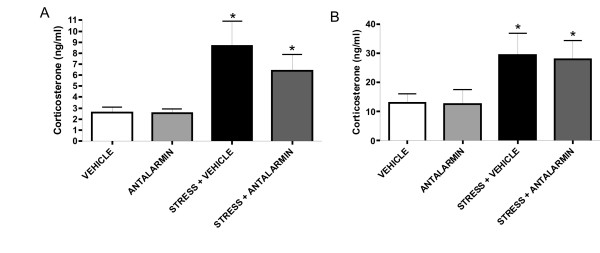
Peripheral administration of antalarmin does not affect the HPA axis response. As described in Materials and methods, levels of corticosterone in serum were determined by RIA in the different groups of mice immediately after the last exposure to stress and on the 4th day of the interval that followed the last exposure to stress. Increased levels of corticosterone upon stress were not affected by the peripheral administration of antalarmin (A). Moreover, increased levels of corticosterone after the last exposure to stress were not affected by antalarmin either, and confirmed the development of chronic stress (B). Data are expressed as MEAN ± SEM. Five animals per group were used. * p < 0.05, compared to control not exposed to stress.